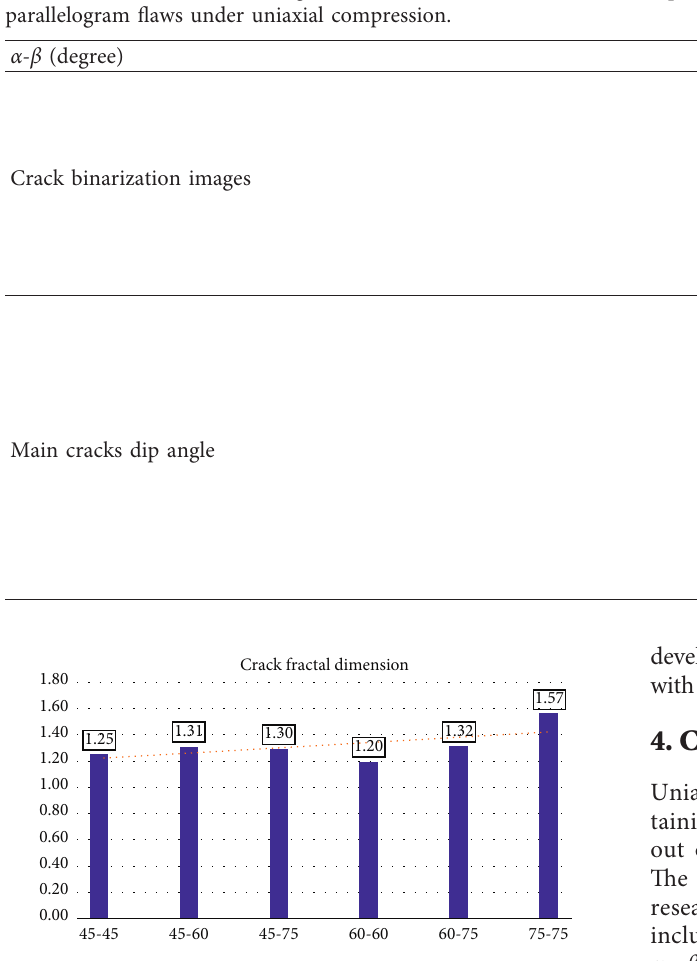
Figure 8: Effects of two preexisting parallelogram flaws on the fractal dimension of surface cracks in ultimate failure modes of the